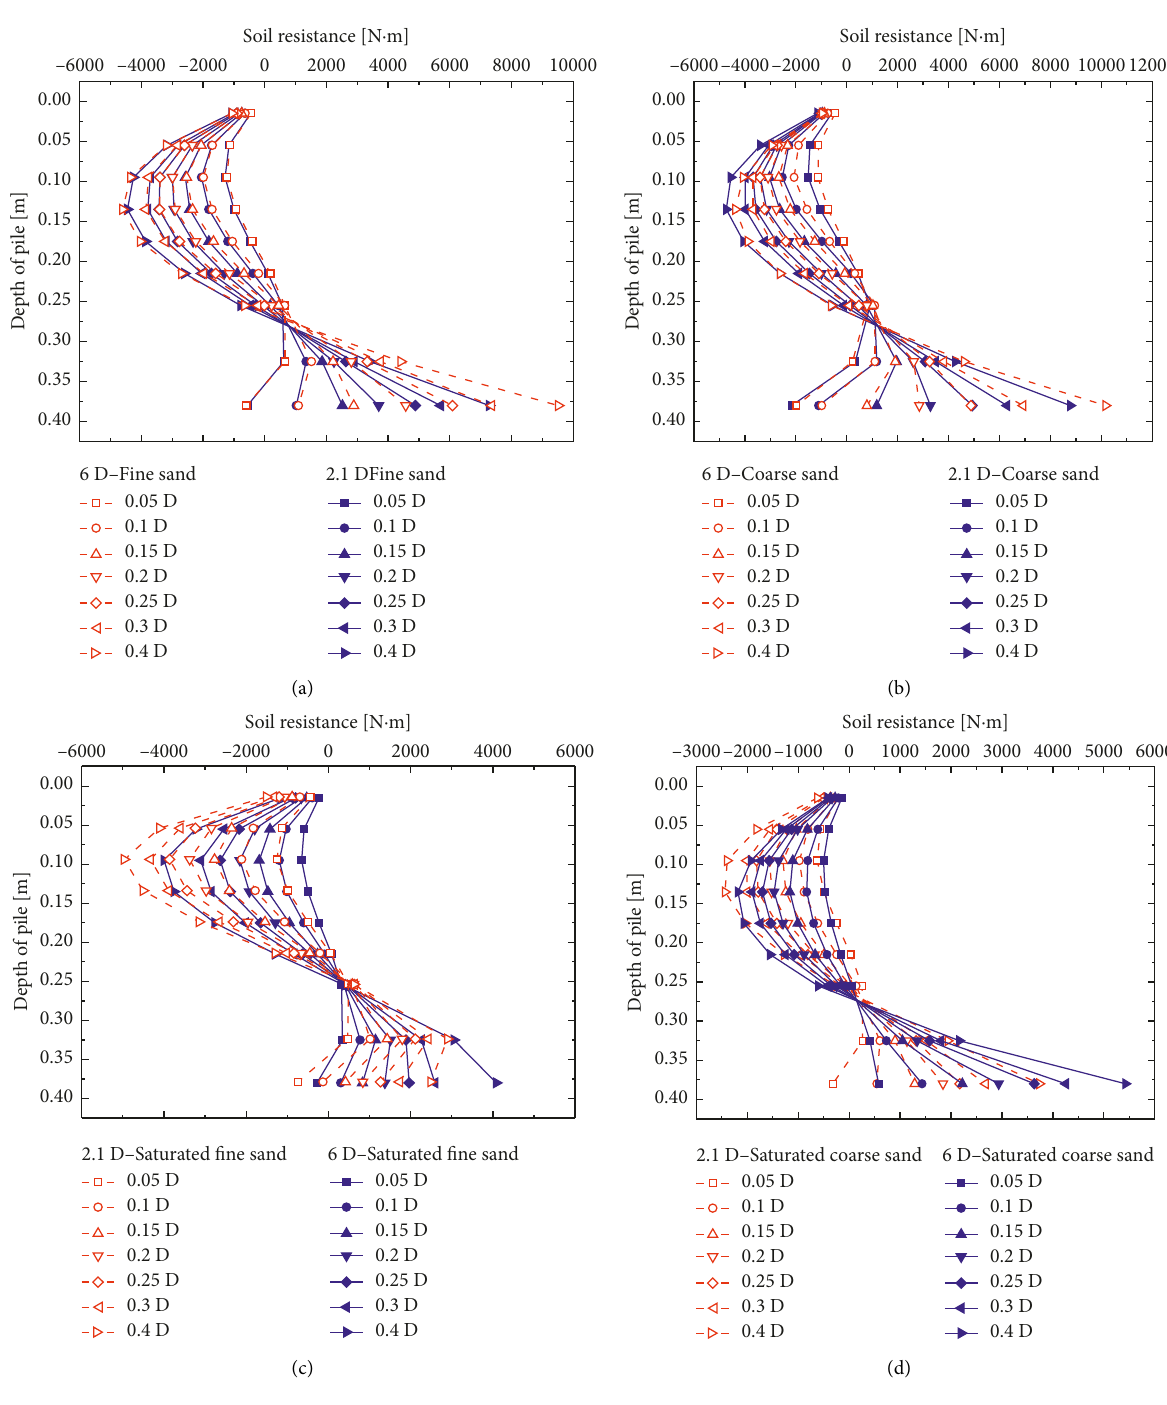
Figure 10: Comparisonofpilesoilresistanceunderdifferentloadingheights.(a)Finesand,(b)coarsesand,(c)saturatedfinesand,and(d)saturated coarse